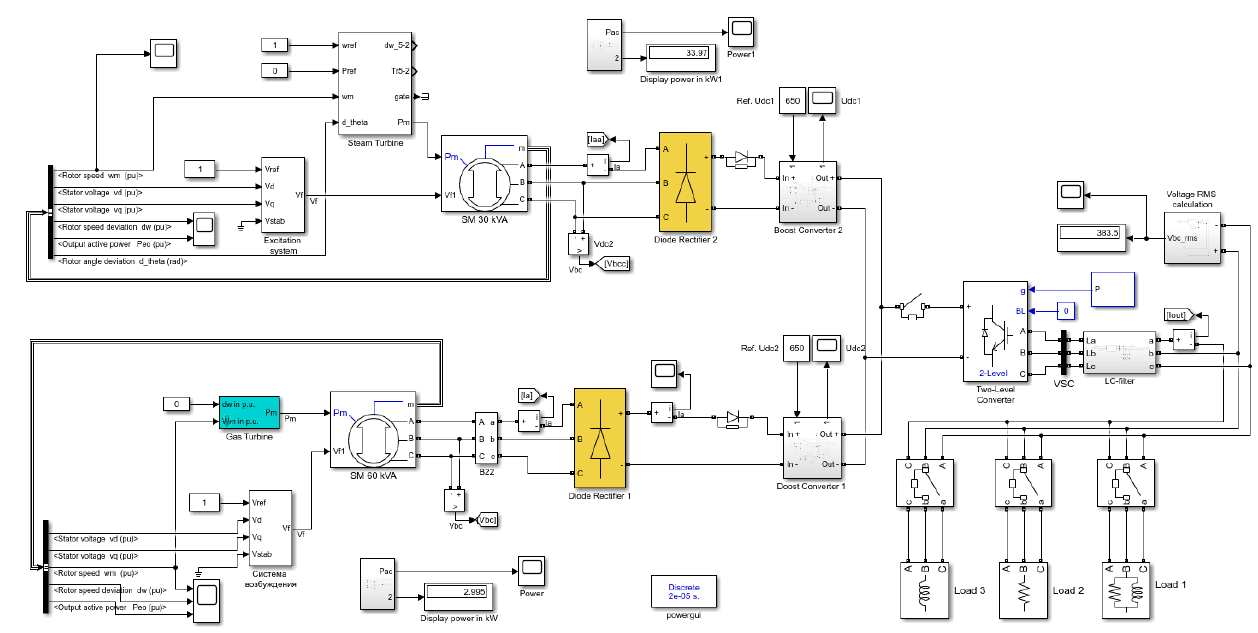
Figure 8. Simulation model for the electrical part of the binary energy system.